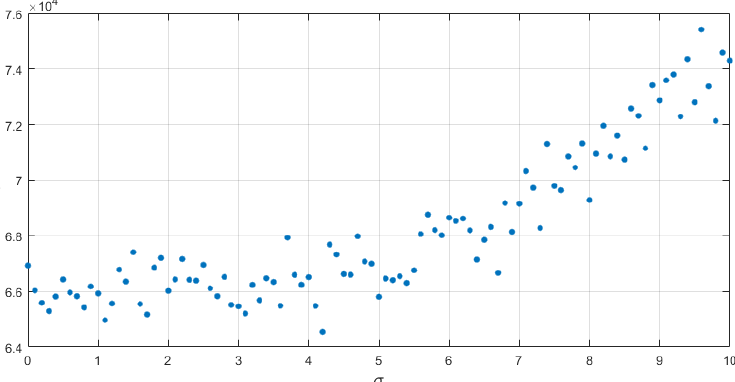
Figure 11. Influence of the scale parameter σ on the average fitness of the generated populations. Each dot represents the average fitness of a population of 10,000 individuals.